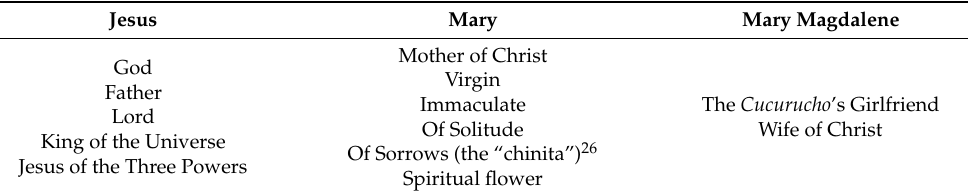
Table 1. Main epithets associated with key venerated